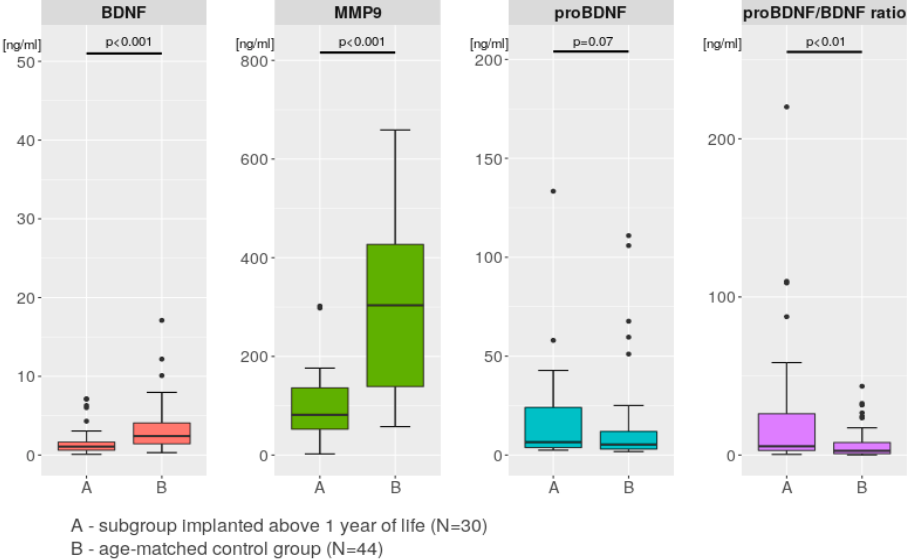
Figure 2. Paired comparisons of the mean plasma levels of MMP-9_18, BDNF_18, and pro-BDNF-18, as well as the pro-BDNF_18/BDNF_18 ratio, measured in the study subgroup implanted after 1 year of life (A, N = 30) and in the age-matched control group (B, N = 44).